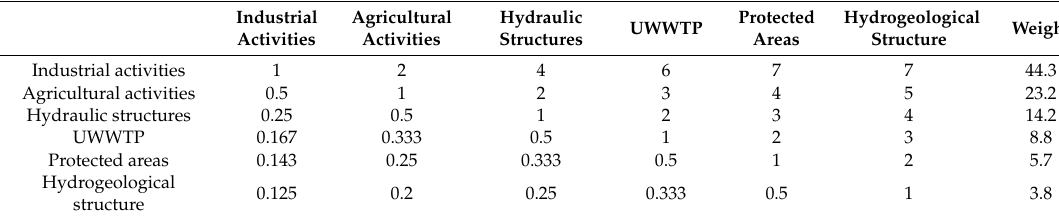
Table 6. Preference matrix with assigned preference values and calculated weights.